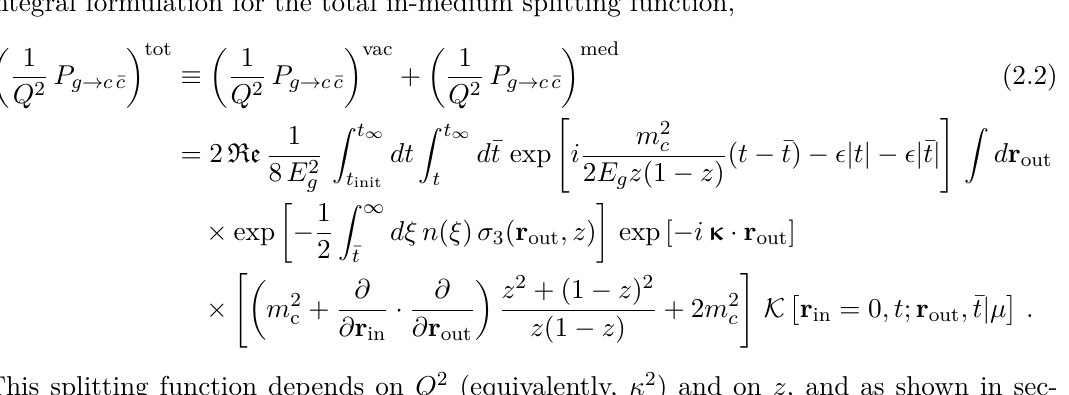
Figure 1 . Configuration space picture of the squared amplitude for the splitting of a gluon of initial transverse momentum k into a c ¯ c -pair carrying final transverse momenta k g momentum fractions z and (1 − z ) , respectively. The splitting occurs at longitudinal positions t ( ¯ t ) in amplitude (complex conjugate amplitude). Taking twice the real part of the contributions for ¯ t > t accounts for contributions from ¯ t < t . Transverse positions of partons are evolved as a function of time ξ in amplitude and complex conjugate amplitude. After integration over the average pair momentum 1 ( k + k ) , the resulting medium-modified g → c ¯ c -splitting function takes c ¯ c 2 the form (2.2). See section 7 for the full